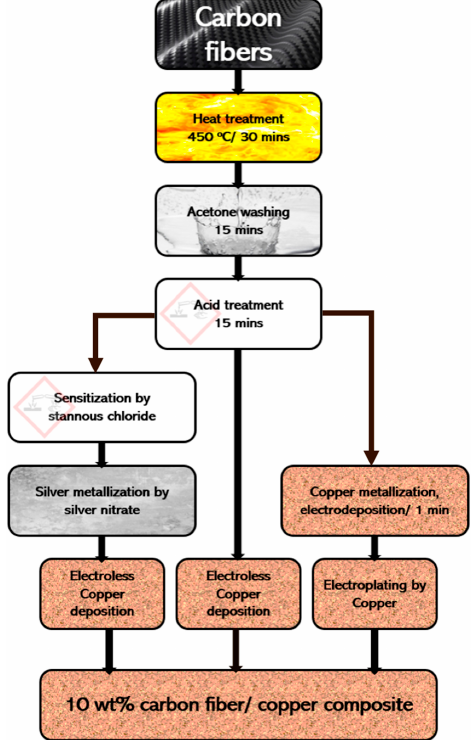
Figure 2. Schematic flowchart of the metallization process of carbon long fibers.